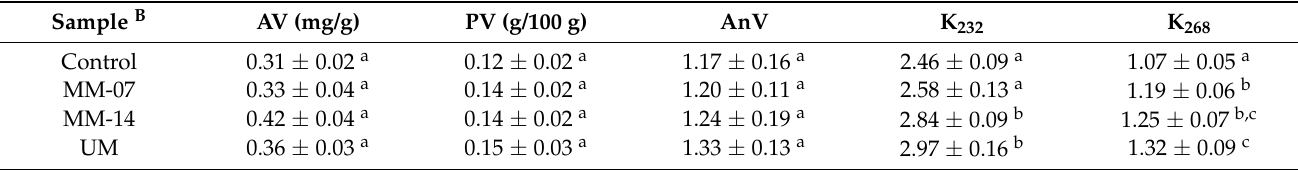
Table 1. The physicochemical properties of SFO samples A .